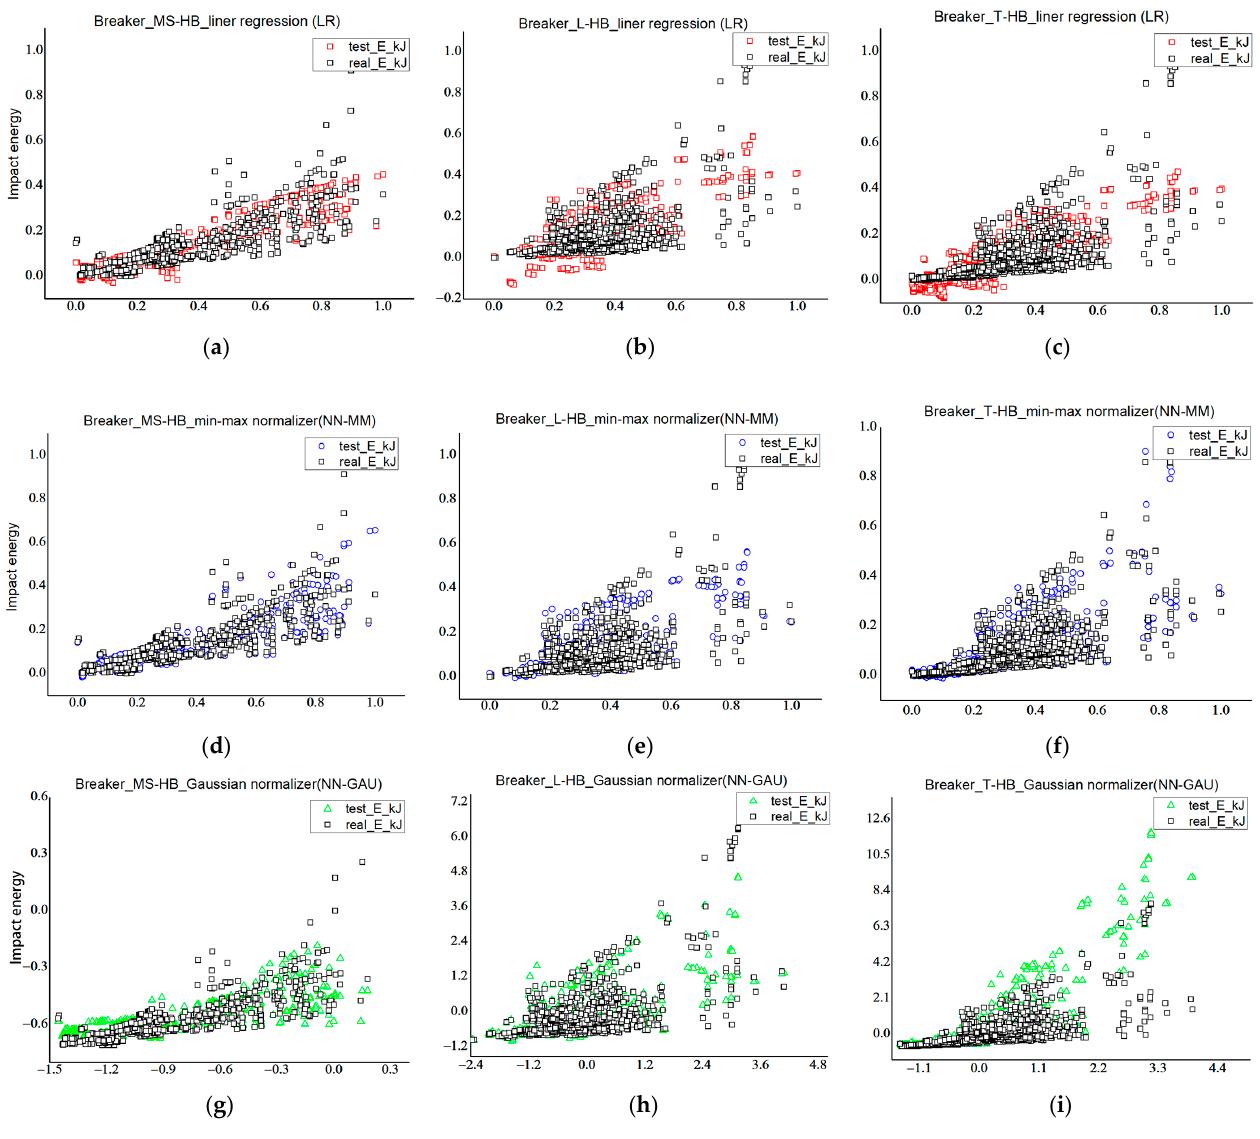
Figure 6. Scatter plot of predicted versus measured impact energy of a hydraulic breaker as: ( a ) linear regression model (LR) of small-to-medium-class hydraulic breaker data set (MS–HB); ( b ) large-class hydraulic breaker data set (L–HB); ( c ) total size class data set (T–HB); ( d ) neural network min–max normalizer model (NN-MM) of small-to-medium-class hydraulic breaker (MS–HB) data set; ( e ) large-class hydraulic breaker data set; ( f ) total size class data set; ( g ) neural network Gaussian normalizer model (NN–GAU) of small-to-medium-class hydraulic breaker (MS–HB) data set; ( h ) large-class hydraulic breaker data set; ( i ) total size class data set.